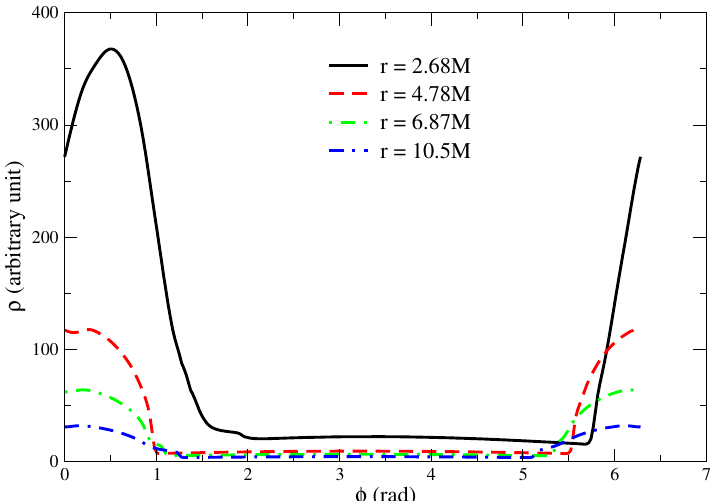
Figure 5. The shock-cone locations as a function of angular distance for asymptotic velocity V ∞ = 0.1 and Gauss–Bonnet coupling constant α =